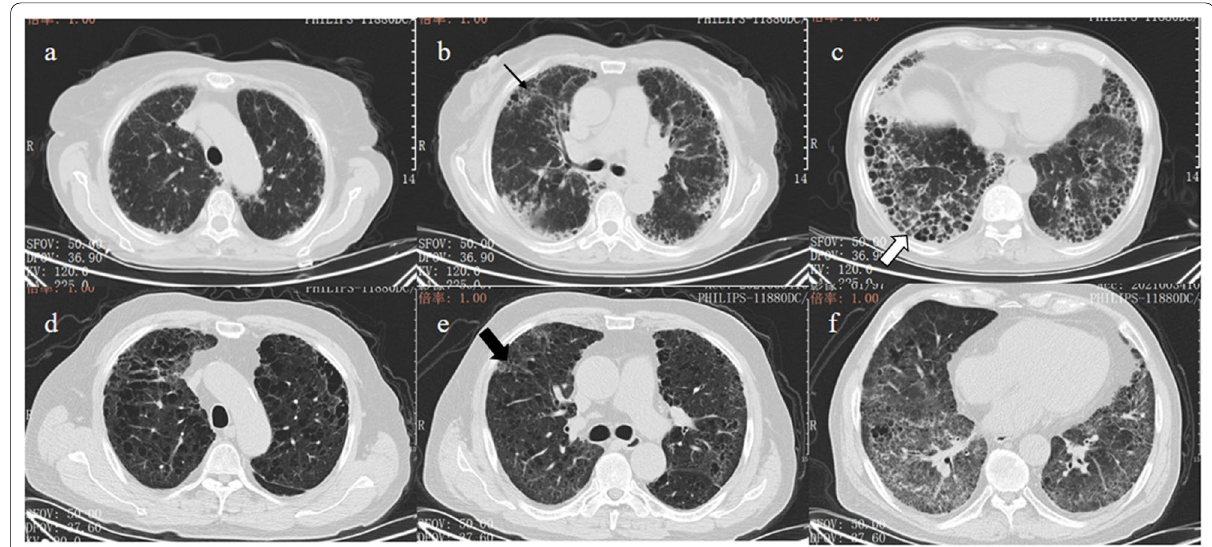
Fig. 1 a – c Three levels of chest CT scores in a middle-aged female with RA-ILD. Her CT findings showed interstitial pneumonia dominated by fibrosis, reticulation ( b ) and honeycombing ( c ) are visible at the arrow marker. We calculated her chest CT score at 15; d – f this is a chest CT of an elderly male patient with AAV-ILD. His CT findings showed interstitial pneumonia dominated by ground glass opacity ( e ), and we calculated his chest CT score at